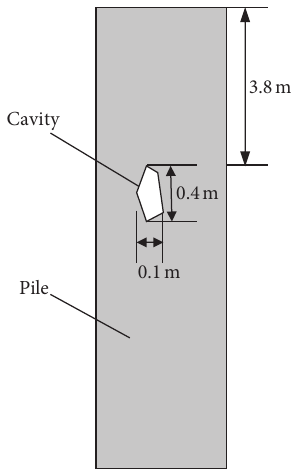
Figure 6: The model of pile with